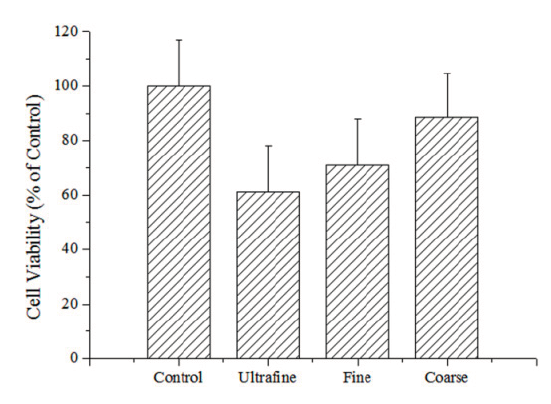
Figure 4. Viability of PM with different sizes to A549 cells after 6 h exposure ( p <